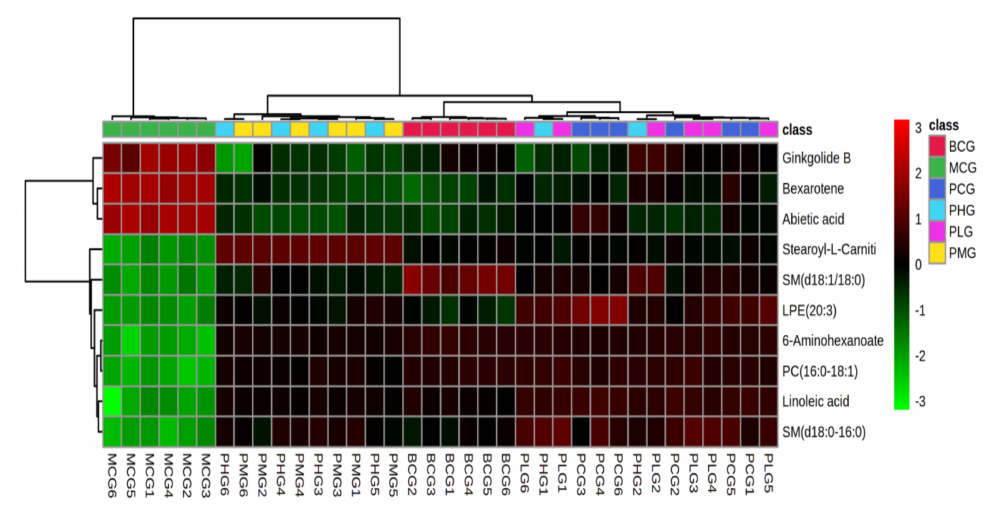
Figure 6. Heatmap visualization and hierarchical clustering analysis results of the differential lipids in each group.